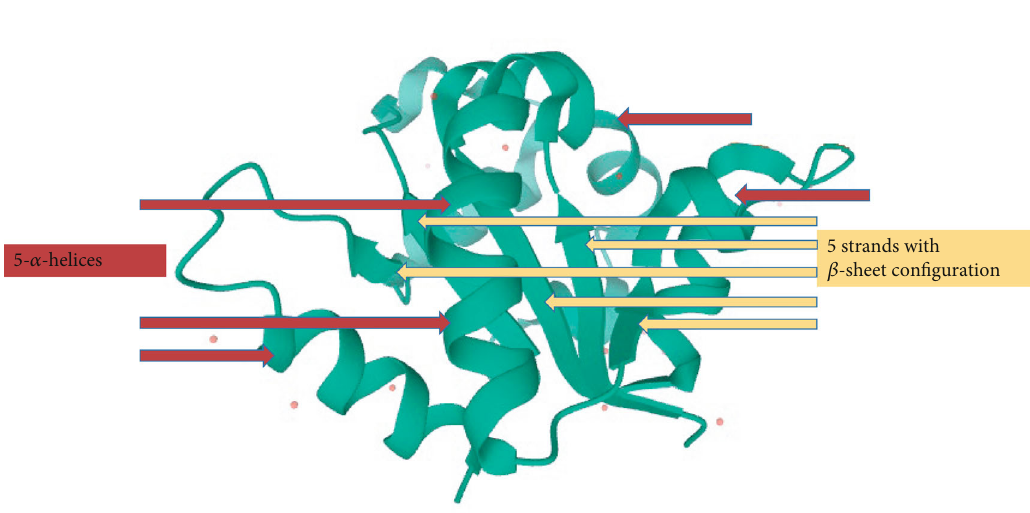
Figure 4: The structure of the TIR domain of TLR6 (4OM7 PDB fi le)